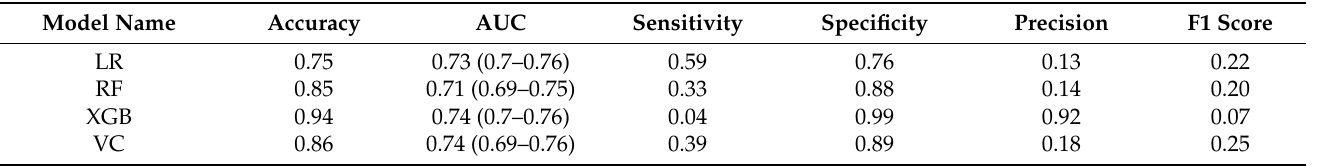
Table 2. All-features model performance for predicting unscheduled return visits within 72 h by patients with abdominal pain.